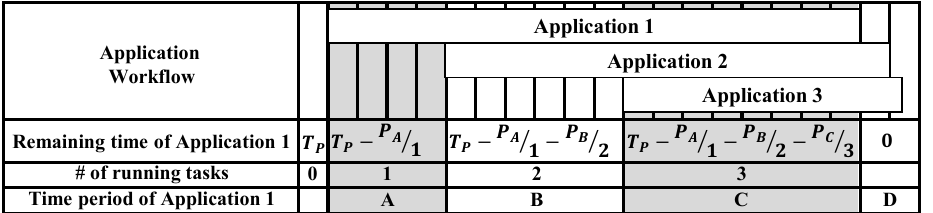
Figure 8. Time-estimation example.